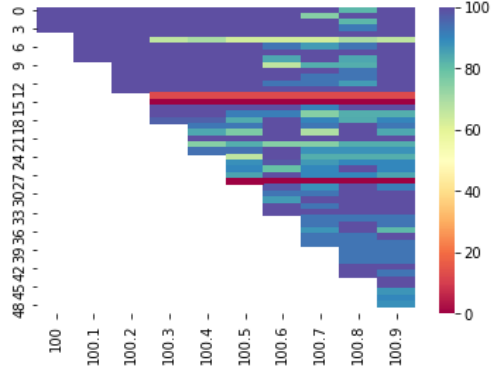
Figure 13. Heat map obtained for datasets of disparate